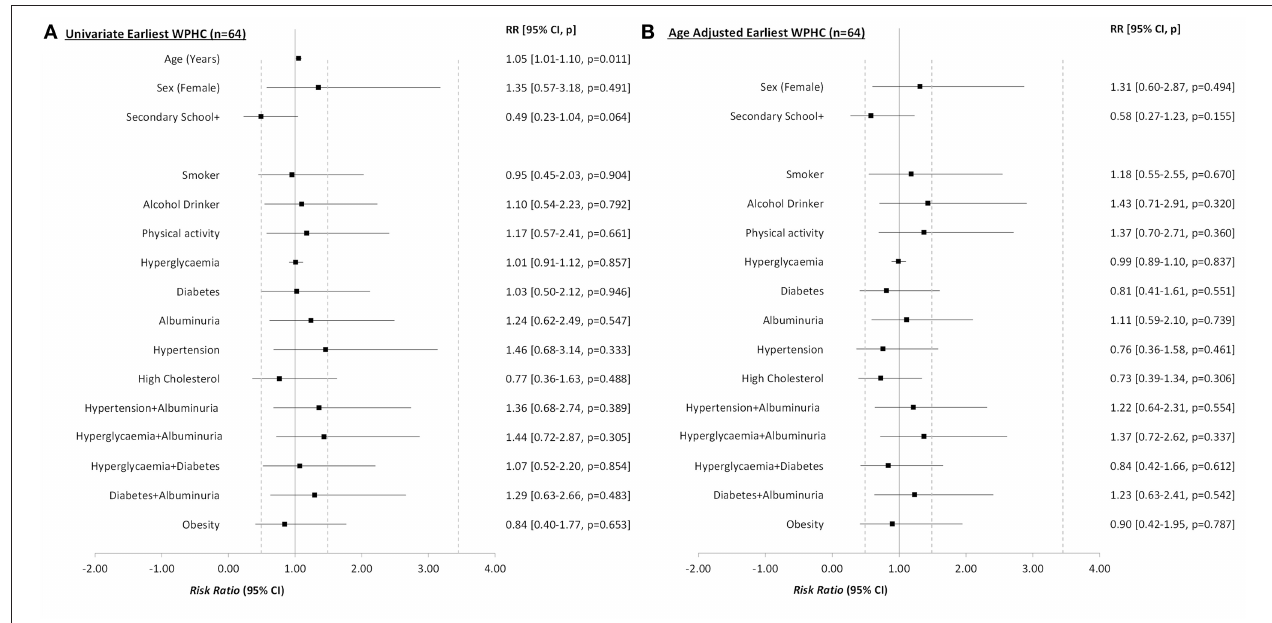
FIGURE 2 | Univariate (A) and age adjusted (B) risk ratios (RR) from generalized linear model analyses of the earliest risk and protective factors for Cognitive Impairment Not Dementia (CIND) or dementia, among 64 Aboriginal and Torres Strait Islander residents who participated in the Well Person’s Health Check (WPHC) (1998/2000, 2005/2006), by dementia status at follow up (2015–2018). Secondary School , Highest education is secondary school or further. +